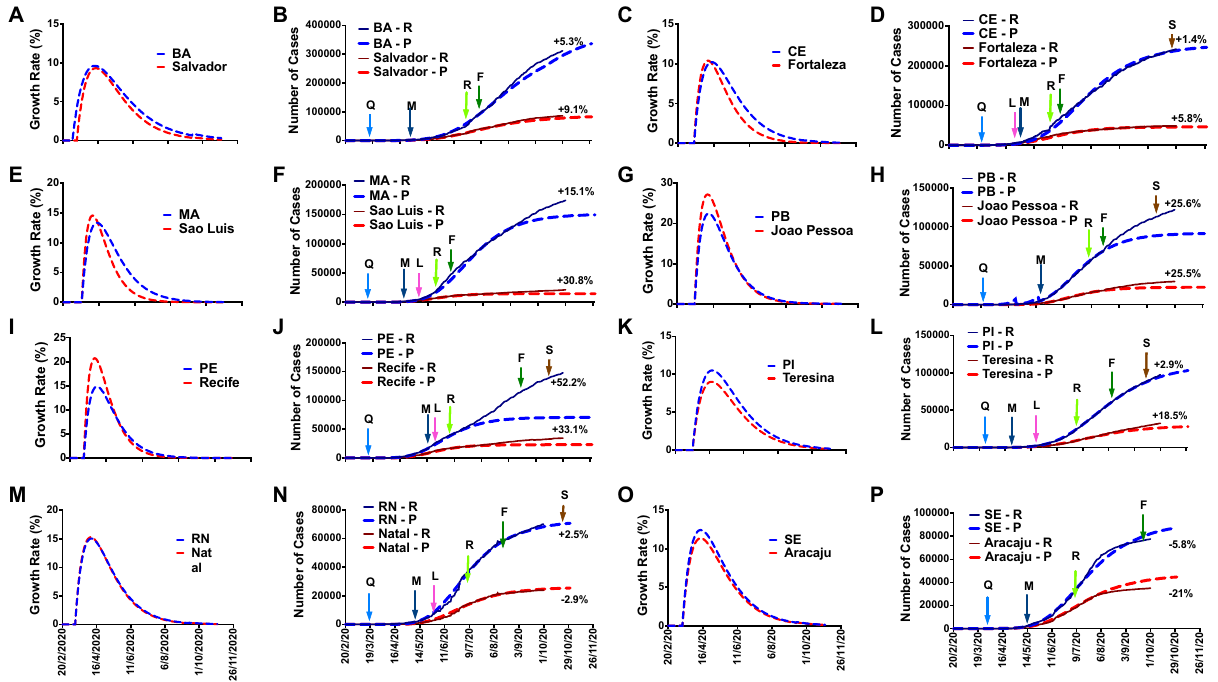
Figure 3. ( A ), ( C ), ( E ), ( G ), ( I ), ( K ), ( M ), ( O ): Cumulative COVID-19 cases; and ( B ), ( D ), ( F ), ( H ), ( J ), ( L ), ( N ), ( P ): Growth rate of COVID-19 in Bahia (BA), Ceara (CE), Maranha (MA), Paraiba (PB), Pernambuco (PE), Piaui (PI), Rio Grande do Norte (RN), and Sergipe (SE), respectively, with their respective capitals. − R: reported number; − P: predicted number; Q: quarantine; L: lockdown, M: mask use; R: reopening; F: flexibilization; S: school